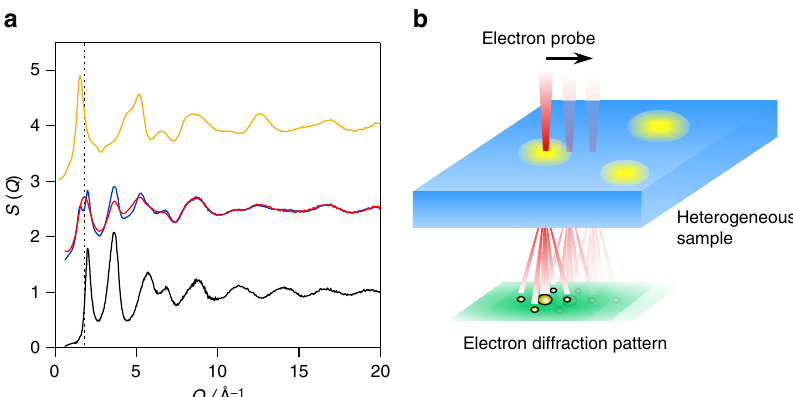
Figure 1 | HEXRD and ABED experiments of amorphous SiO. ( a ) X-ray total structure factors S ( Q ) of amorphous SiO, Si and SiO 2 . The X-ray S ( Q ) of amorphous SiO obtained from HEXRD (red) is shown together with the S ( Q ) data of amorphous Si (black) and SiO 2 (orange) reported in the refs 15 and 19, respectively. The S ( Q ) profile for the summation of amorphous Si and SiO 2 is shown as a blue curve. The dotted line is a guide to the eyes. The weighting factors of Si–Si, Si–O and O–O pairs for X-rays used in the RMC modelling are plotted in Supplementary Fig. 10, together with those for electrons. ( b ) The schematic diagram of the ABED measurements of amorphous SiO with nanoscale structural heterogeneity. Nano-regions indicated by yellow colour are structurally different from those indicated by blue colour. Diffraction patterns from yellow and blue nano-regions, and also their interface can be acquired by using ABED